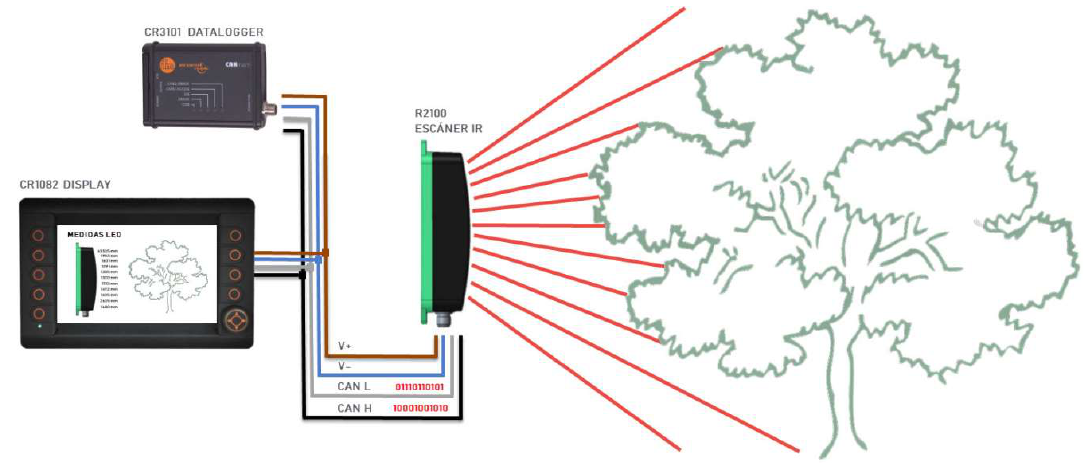
Figure 2. Electronic arrangement of the 2D LiDAR scanner.